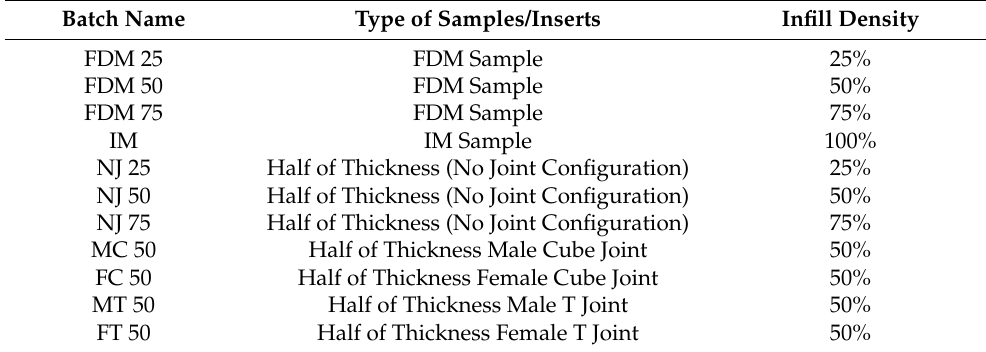
Table 3. Range of samples.